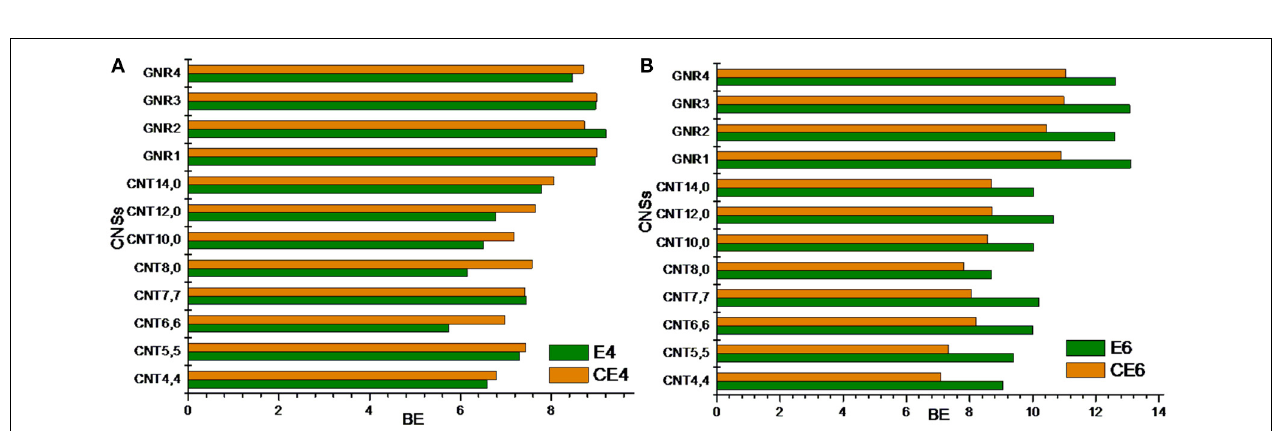
FIGURE 6 | Binding energy of cyclic vs. acyclic saturated hydrocarbons. (A) n-butane vs. cyclobutane and (B) n-hexane vs. cyclohexane.